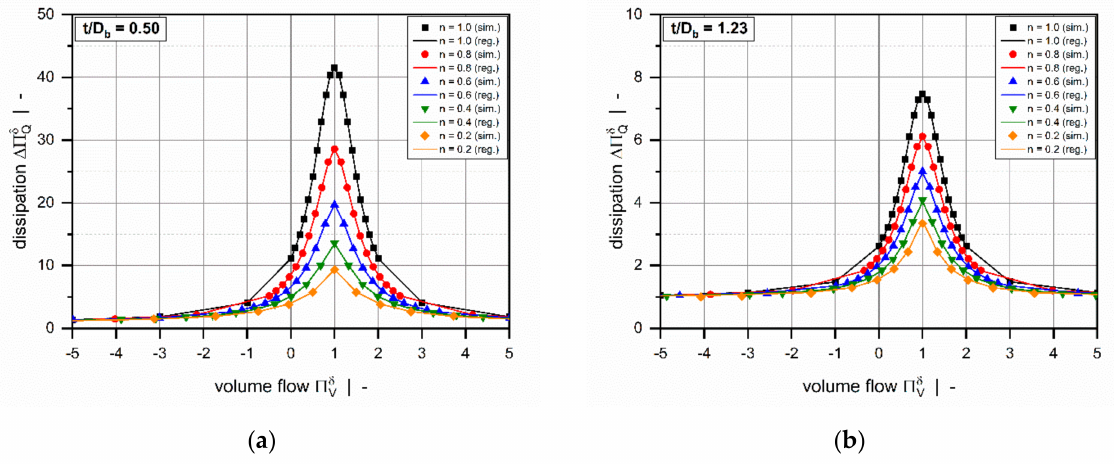
(cid:16) (cid:17) = f t / D b , n , Π δ and numerical solutions for V Q